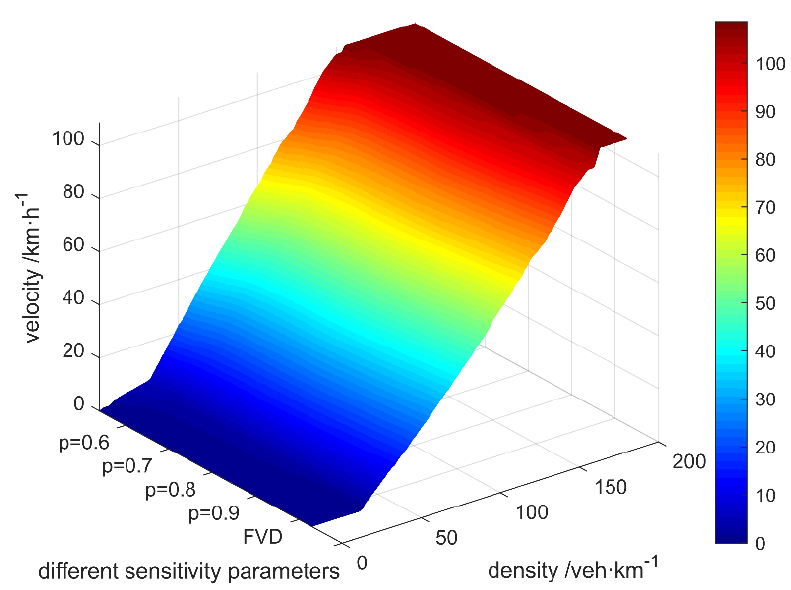
Figure 7. The velocity–density surface.